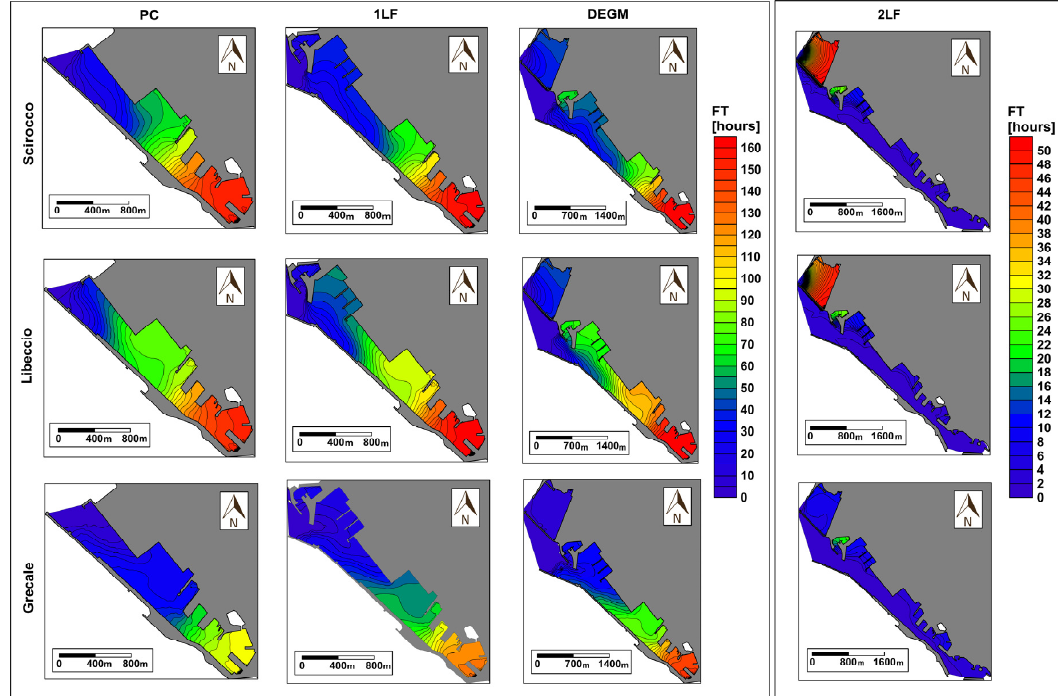
Figure 4. Spatial distribution of FT within the Civitavecchia port calculated in different weather conditions (rows) and harbour configurations (columns). The FT is expressed in hours.